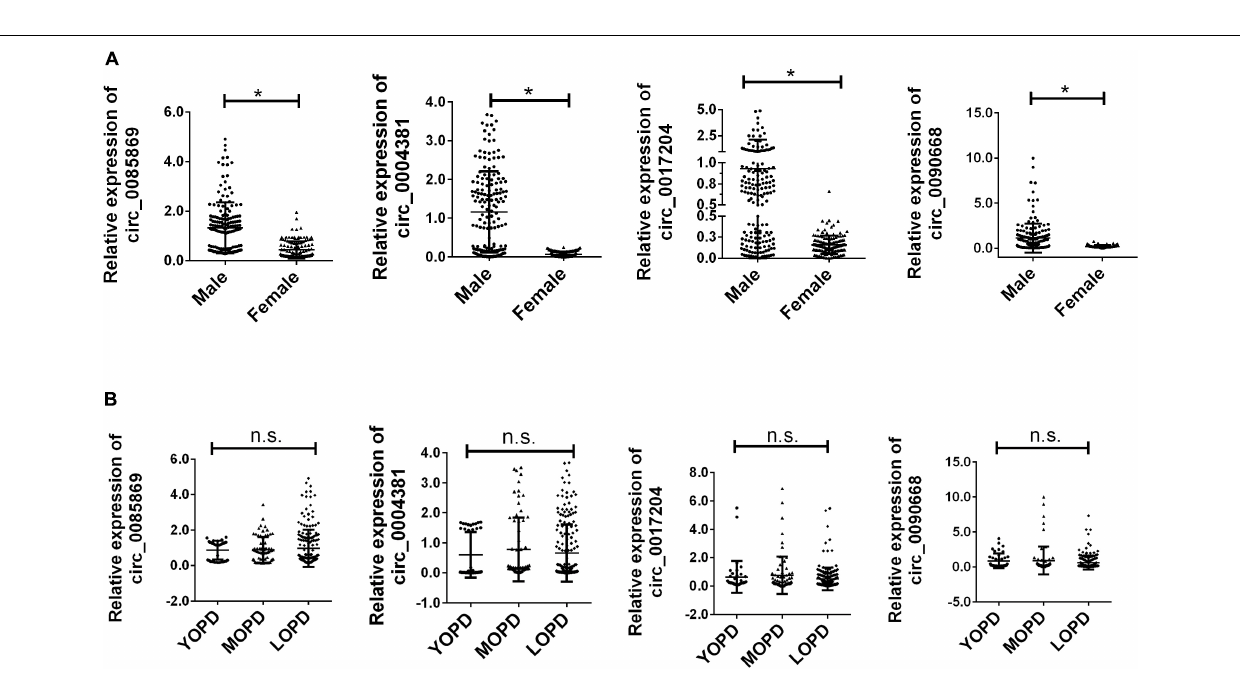
Frontiers in Aging Neuroscience |